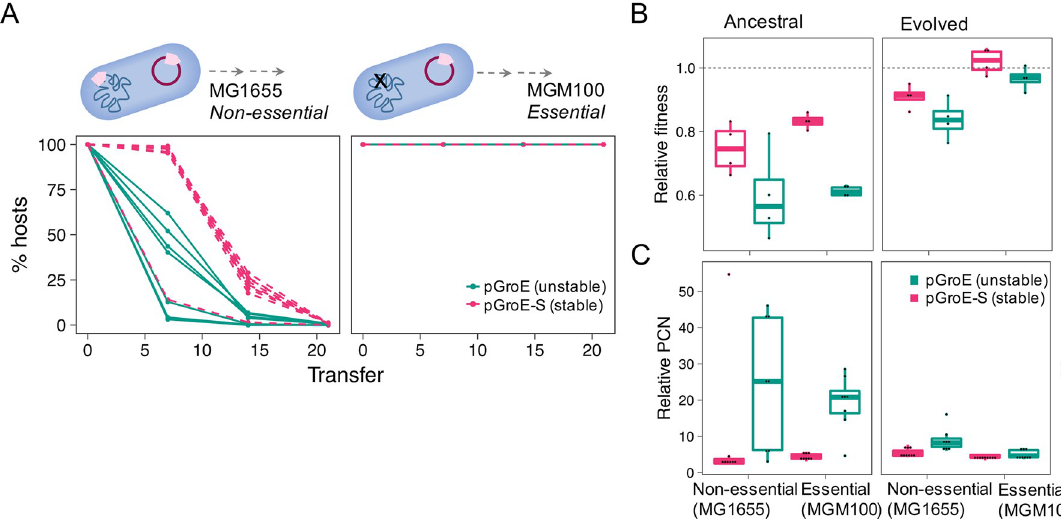
Fig 4. Evolution of plasmids encoding an essential gene. A, Evolution experiment of pGroE (unstable) and pGroE-S (stable) in the host strains E . coli MG1655 (non-essential, left) and MGM100 (essential, right). B , Relative fitness of plasmid-carrying ancestral and evolved populations. Pairwise competition experiments between the plasmid-carrying strains and tagged wild-type (Tm r ). A significant negative fitness effect could be observed for all ancestral populations ( w : 0.69, P = 1.526x10 -5 using Wilcoxon test, n = 4 per population) while the fitness of evolved populations increased compared to the ancestral state ( w : 0.93, P = 9.05x10 -7 using Wilcoxon test, n = 4 per population). C , Plasmid copy number (PCN) of plasmid-carrying ancestral and evolved populations. The median pGroE PCN is significantly different between the ancestral and evolved populations ( P = 0.03, P = 0.0016, using Wilcoxon test, n = 9 per MG1655 MGM100 population), with the PCN being lower in the evolved populations in both hosts.